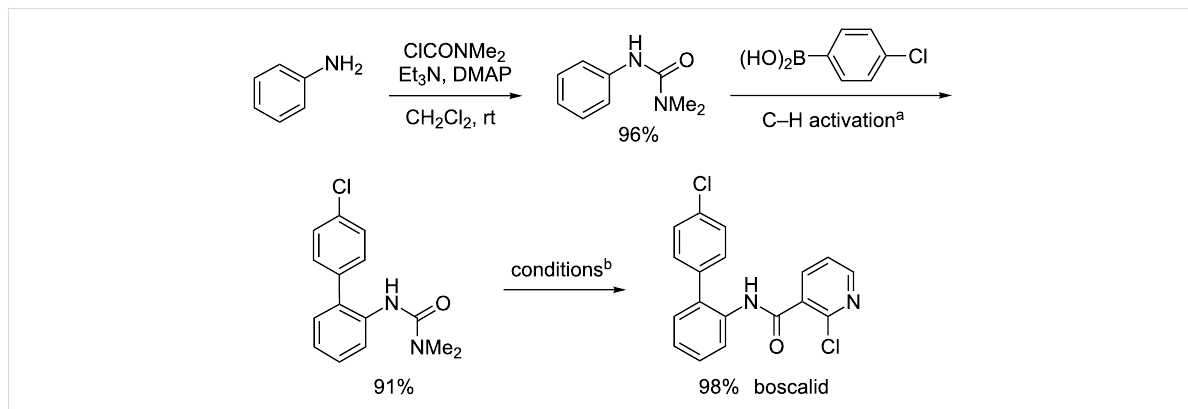
Scheme 7: Synthesis of boscalid ® . a Conducted at rt for 20 h in EtOAc with 10 mol % [Pd(MeCN) 4 ](BF 4 ) 2 , BQ (5 equiv), arylurea ( 1 , 0.25 mmol), and